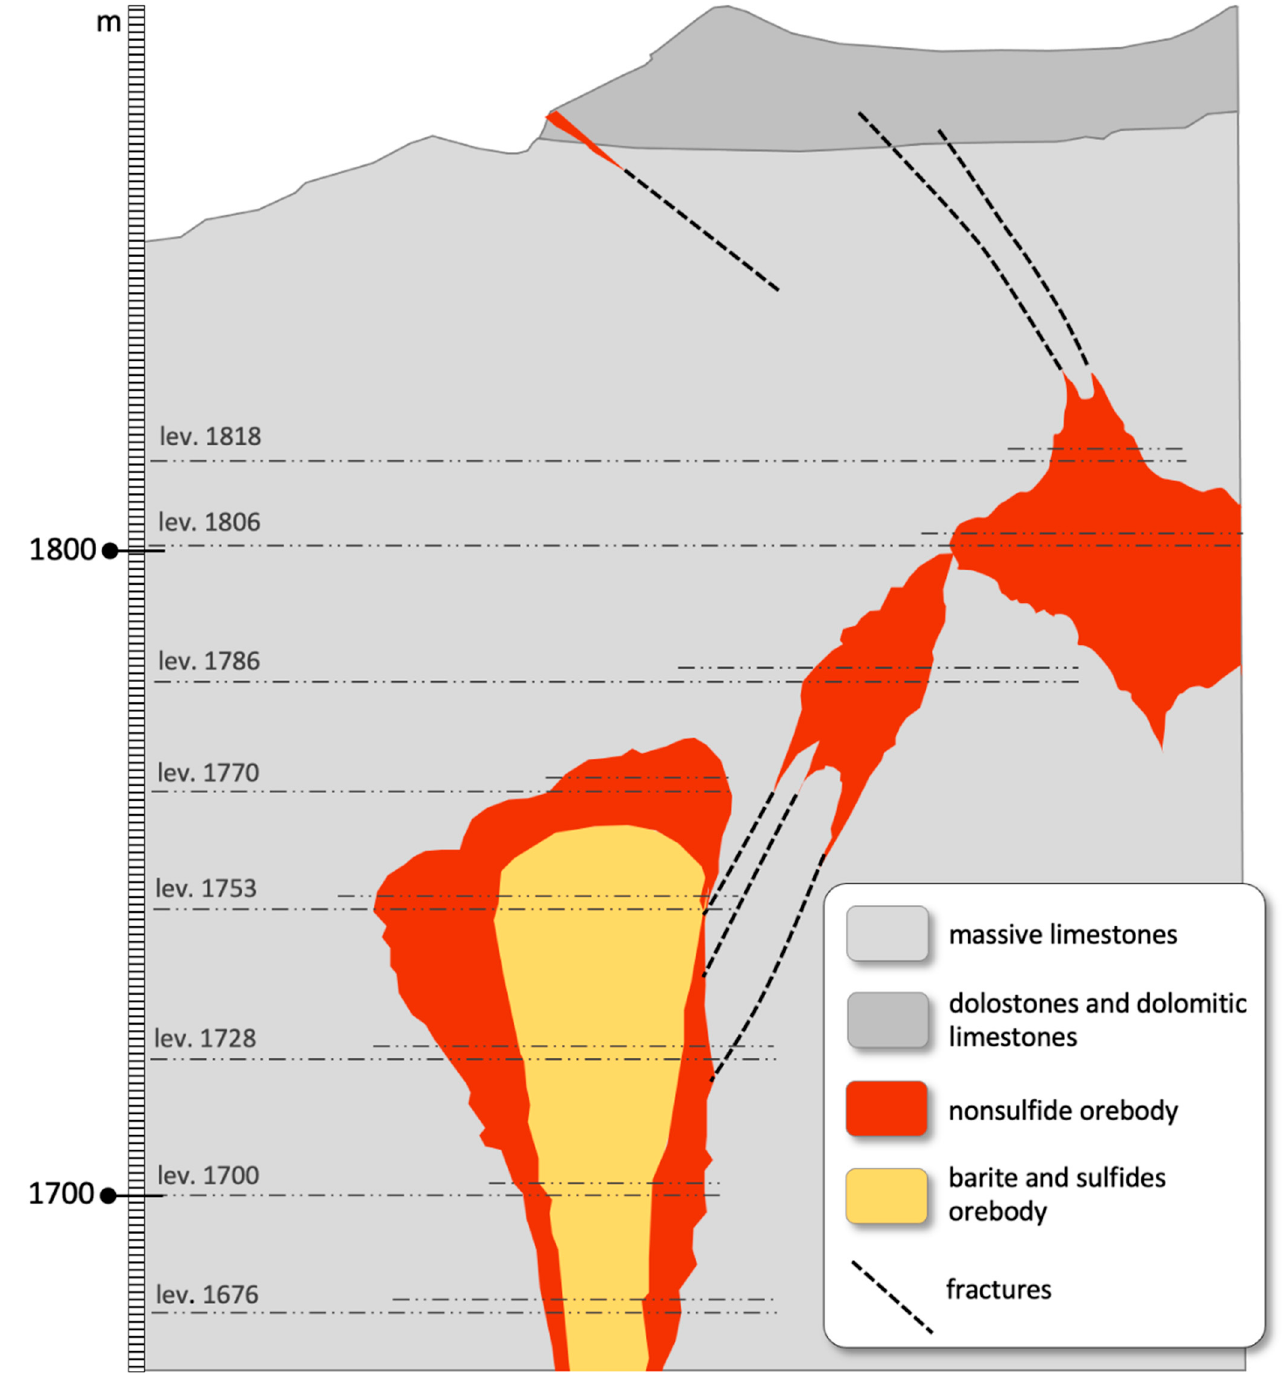
Figure 3. Grand Pic vertical section (adapted from [21], and the references therein).